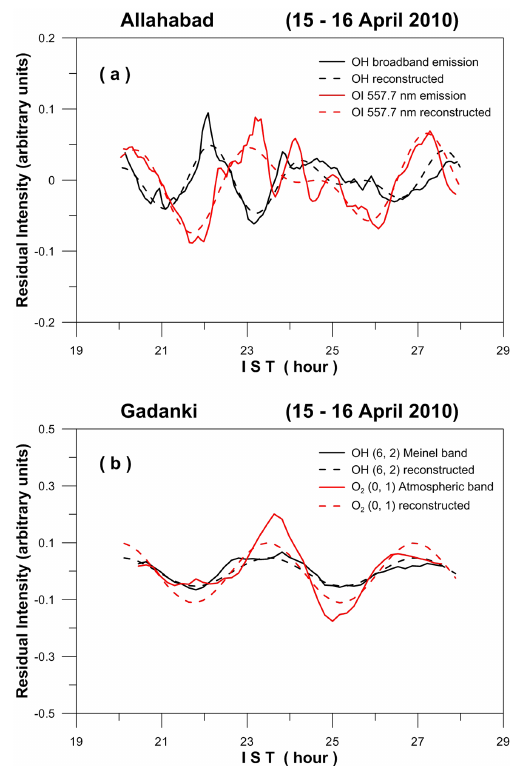
Figure 12. As Fig. 9, but for 15–16 April